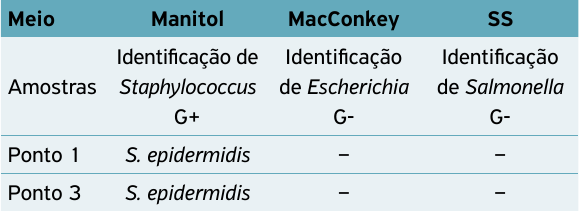
Figura 2. Instalação de uma armadilha: (A) armadilha contendo isca de 2 mL de mel; (B) coleta do material para análise.